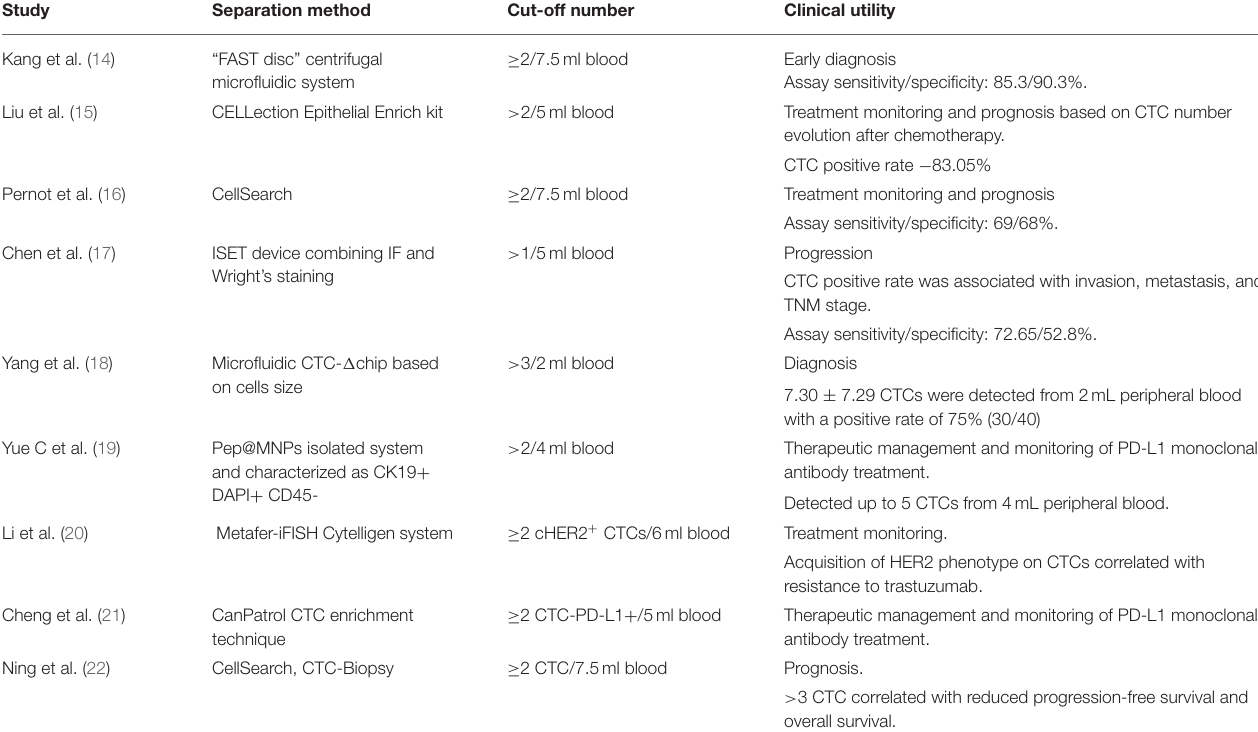
TABLE 1 | Clinical utility of CTCs in GC. Study Separation method Cut-off number Clinical utility